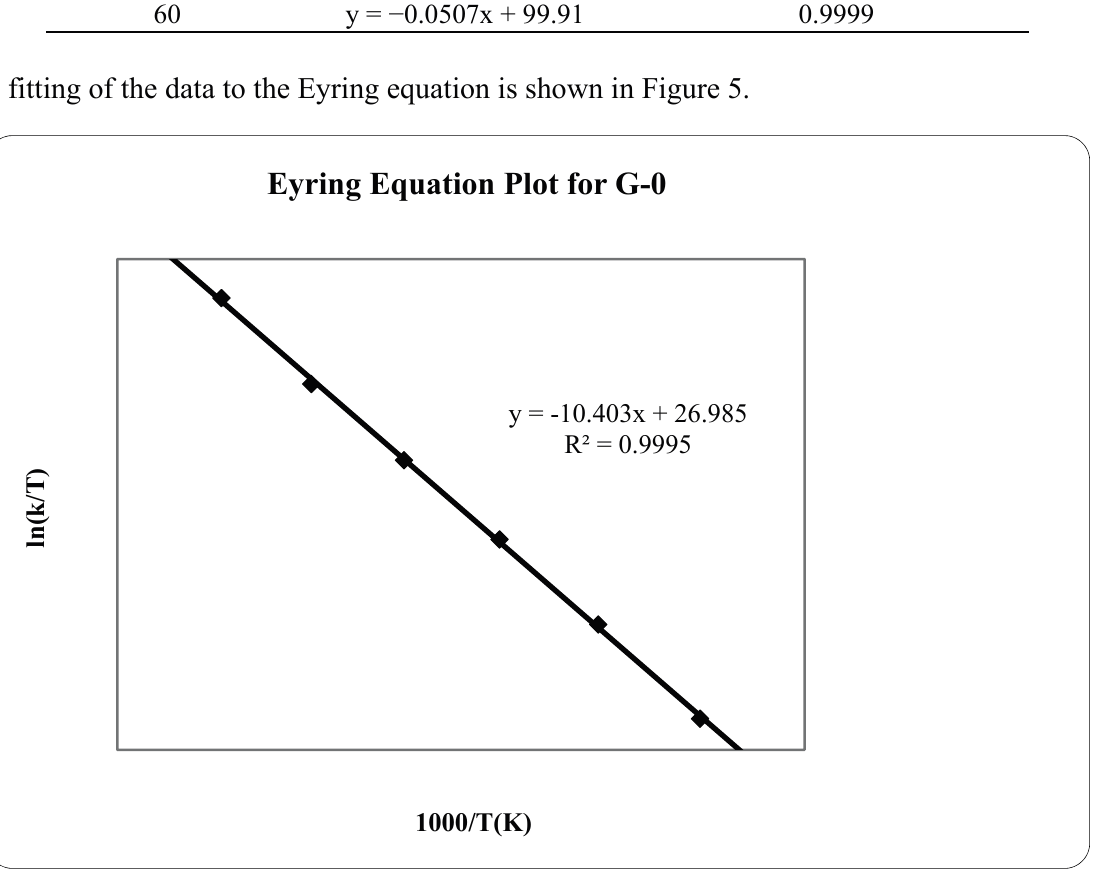
Figure 5. Eyring plot for the G-0 sublimation